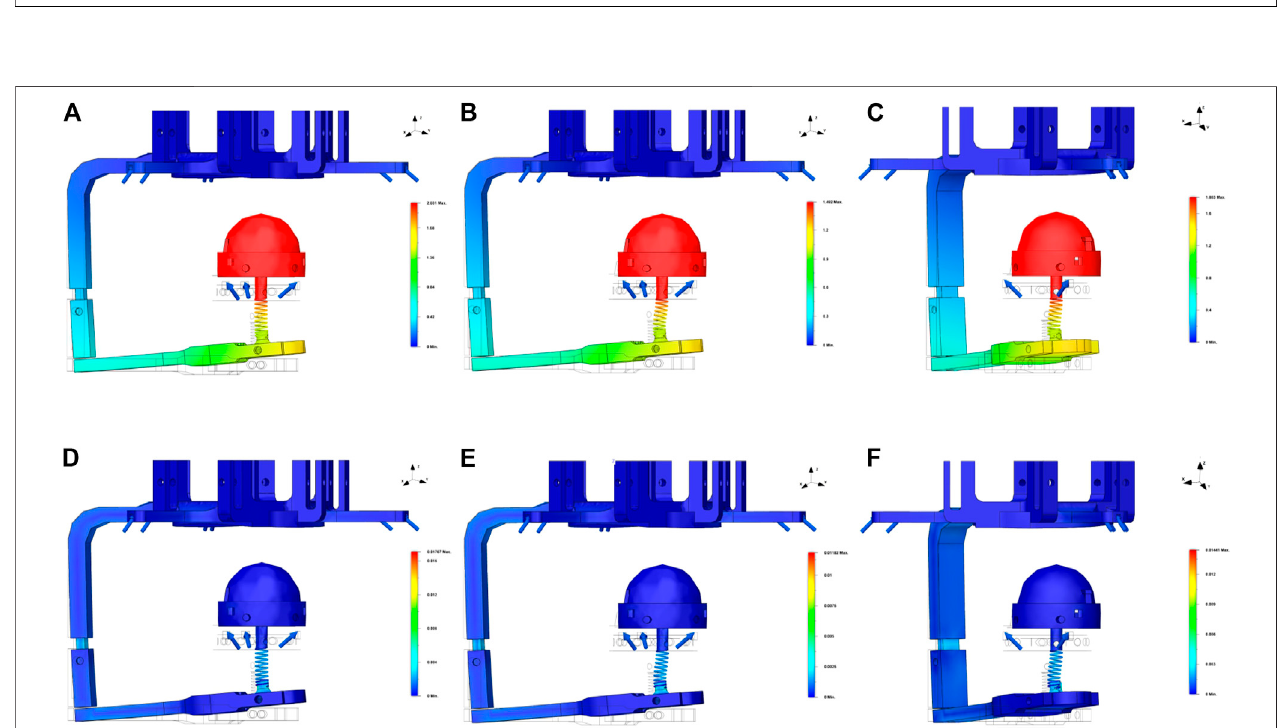
FIGURE6| Results oftheFEM structural analysis.Theblue arrows indicatetheforcesapplied inthesimulations,thewireframetransparentCADmodelrepresents the undeformed model, while a 1X deformation of the device is represented in the colored surfaces. (A) The displacements when a force with only a z-component is applied, (B,C) show,respectively,theresultsofthedisplacementswhenaforcewithaz-componentandanx-componentoray-componentisapplied;sub fi gures (D – F) on the right side report the results of the deformation for the same loading cases.